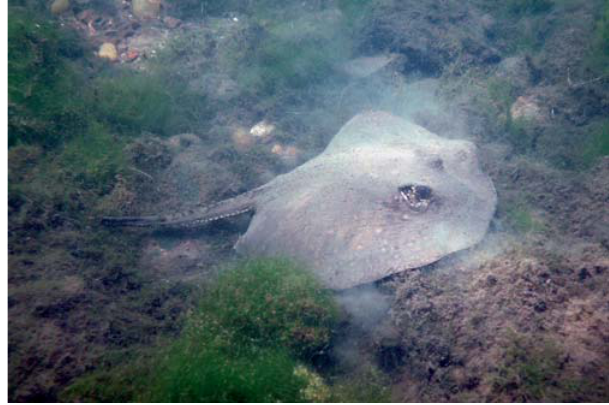
Fig. 1. A freshwater ray ( Potamotrygon motoro ) forages with use of “undulate the disc and stir substrate” tactic. Note fine clouds of sediment adjacent to the ray.